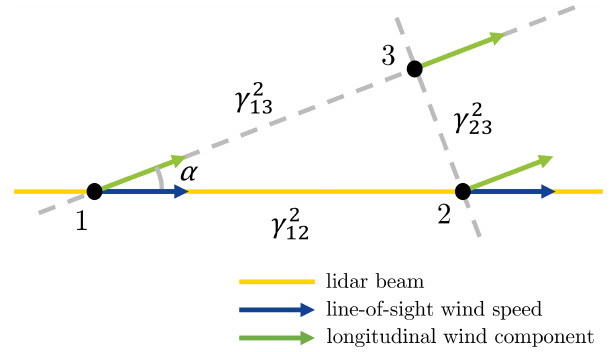
Figure 3. Misalignment of wind direction and lidar measurement. α is the misalignment angle. γ 2 is the coherence of the line-of-sight 12 wind speed. γ 2 and γ 2 are the longitudinal and lateral coherence, 13 23